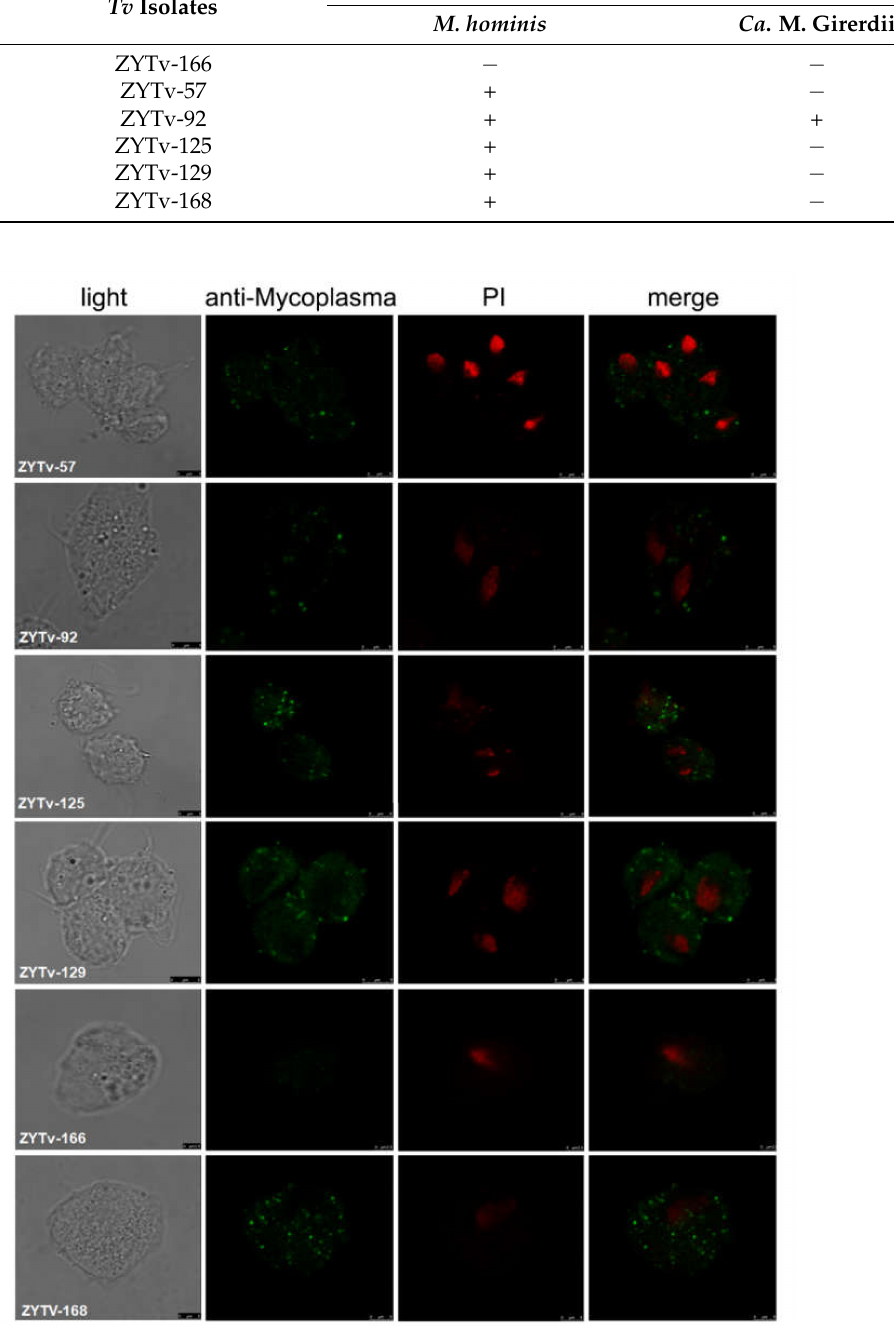
Figure 2. The cellular localization of M. hominis in Tv isolates. Four panels represent the same area of a protozoan monolayer immunostained as described in Materials and Methods. Light: surface image of Tv ; anti- Mycoplasma : FITC fluorescence showing intracellular M. hominis (green); PI: images of the nucleus of Tv after PI staining (red); merge: superimposed panels of anti- M. hominis and